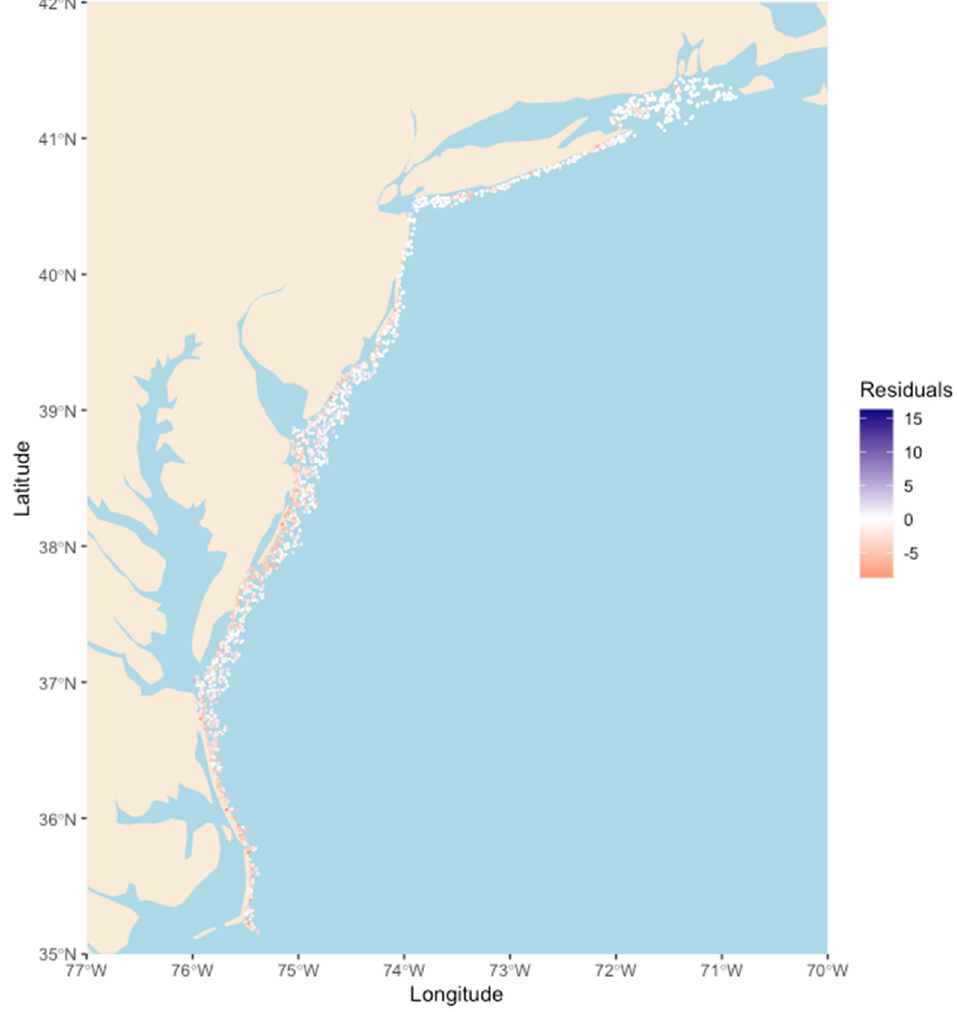
Figure A5. Map of residuals from delta SAR lag model fitted to NEAMAP weakfish survey data. Blue indicates positive, red indicates negative, and color darkness is proportional to the value of residuals.